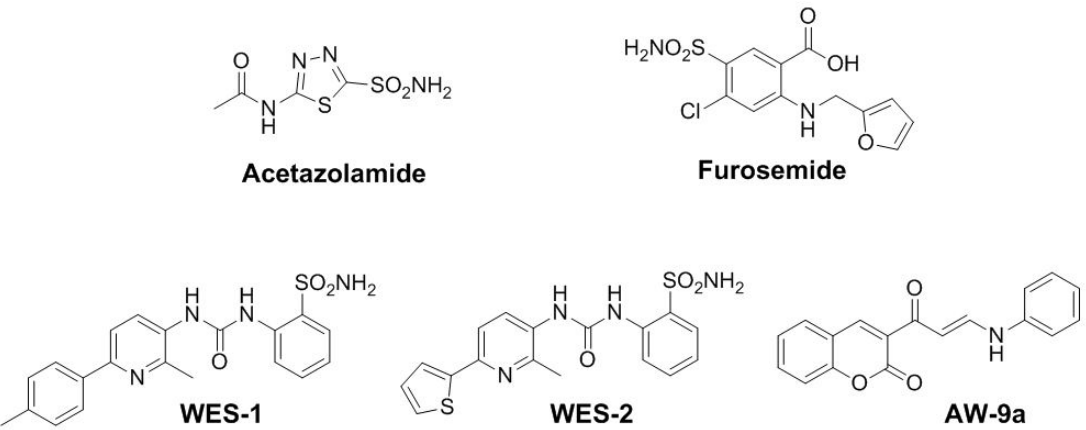
Figure 1. Chemical structures of the clinically approved (acetazolamide and furosemide) and newly synthesized ( WES-1 , WES-2 , and AW-9a ) carbonic anhydrase inhibitors.